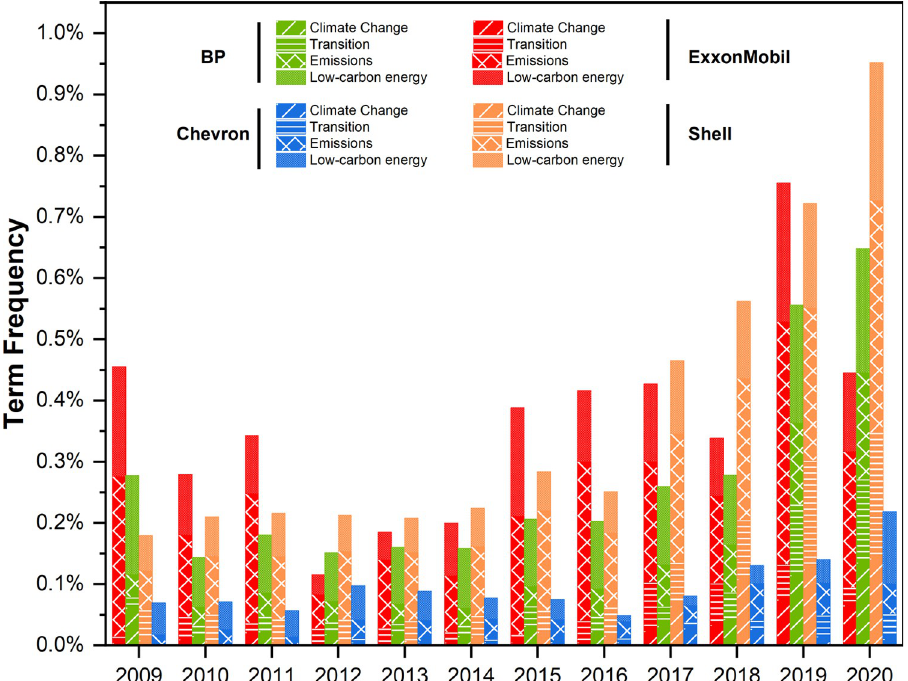
Fig 1. Frequency of keyword mentions in annual reports (normalized by total word count). Note: Results for ExxonMobil are affected by the style of reports examined (all years except 2020 are summary reports).